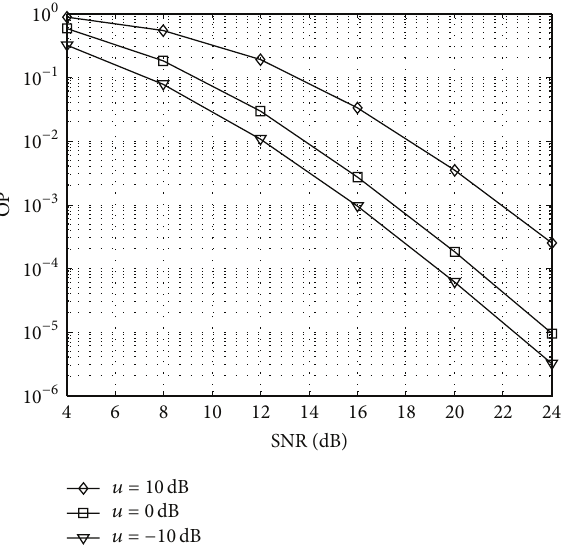
Figure 4: The effect of the relative geometric gain 𝜇 on the OP performance.